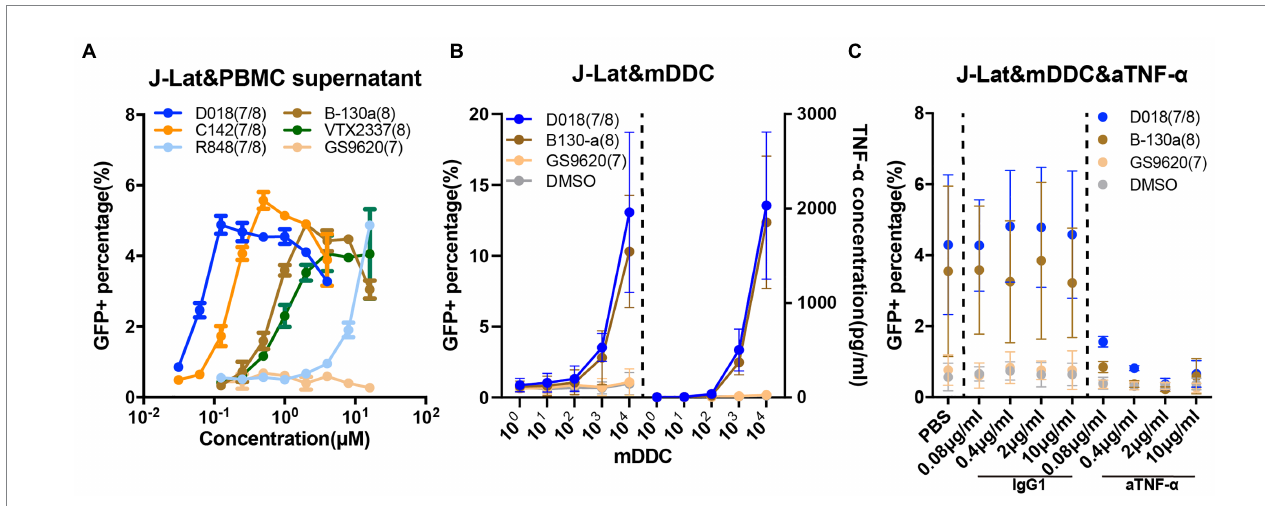
FIGURE 4 TLR7/8 agonists indirectly activate latent HIV-1 from the J-Lat CD4 T cell line through TNF- α . (A) Dose–response curves for HIV-1 activation in J-Lat CD4 T cell line by the selected novel and control TLR7/8 agonists. The GFP+ percentage indicated the proportion of J-Lat activated. Data are shown as mean ± SD of 2 independent experiments). (B) Dose–response curves for HIV-1 activation and TNF- α release in the J-Lat and mDDC co-culture system 48 h after stimulation by D018, B130-a, GS9620, and DMSO. Data are shown as mean ± SD ( n = 4). (C) Dose–response curves for HIV-1 activation of J-Lat CD4 T cells with varying concentrations of anti-TNF- α monoclonal antibody compared with that of irrelevant IgG1 antibody control, 48 h after stimulation by D018, B130-a, GS9620, and DMSO. The GFP+ percentage indicated the proportion of J-Lat activated. Data are shown as mean ± SD ( n =